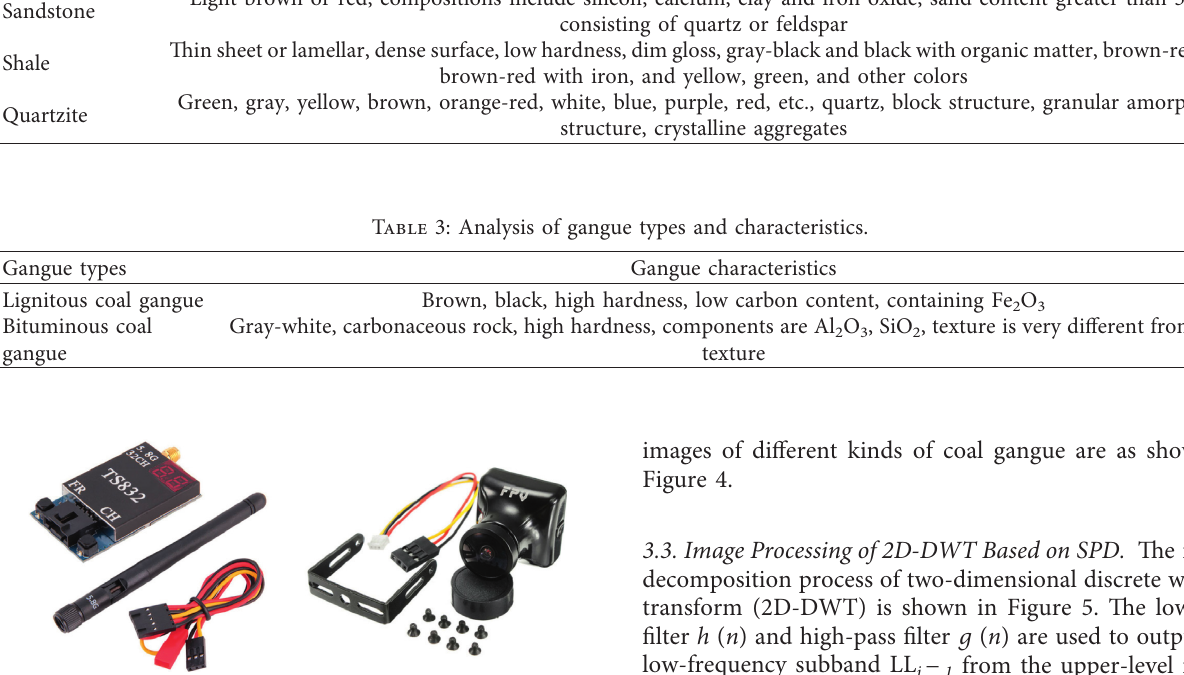
Figure 1: Module and HD camera.